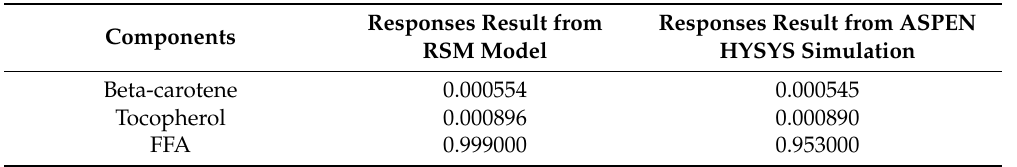
Table 11. Predicted result from the Response Surface Methodology (RSM) model and ASPEN HYSYS Simulation.